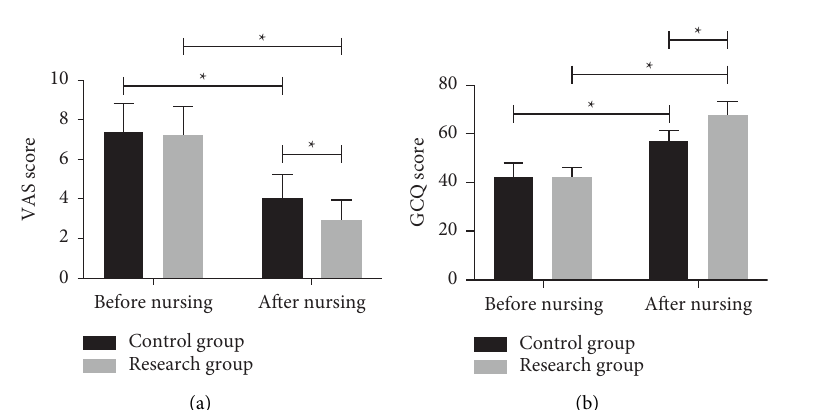
Figure 2: Comparison of pain between two groups. Note: (a) comparison of VAS scores before and after nursing; (b) comparison of GCQ scores before and after nursing. ∗ P <